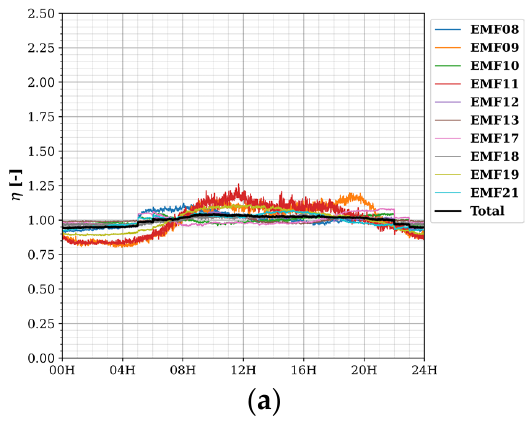
Figure 6. ( a ) Maximum and ( b ) 90% temporal variability of the signals. The maximum variability is calculated as the logarithmic difference of the maximum and minimum electric field samples, 20log 10 (E max /E min ), whereas 90% equals the difference between the 95th and 5th percentiles [13]. All measured exposure levels were low (<0.05%) compared to the ICNIRP reference levels for the general public (e.g., 41 V/m for 900 MHz) [15]. Then, as in [13], temporal profiles (TPs) of the RF exposure were made, which express the average variation of the exposure, η , over a certain time interval (in this case a week and a day). To determine η , the power density samples were first normalized to the average of the considered time interval and then averaged over the entire measuring period. The goal of a TP is to improve (spatiotemporal) interpolation of the RF-EMF exposure (e.g., [13]) by rescaling samples taken at different times of the day or week to the same time instance. For example, a TP can be applied in measurement campaigns where only a single or a few measurements have been performed at each assessment location, each at a different time of day. In this study, both diurnal and weekly temporal profiles (denoted as TP D and TP W , respectively) were created. In contrast to the fixed temporal resolution (denoted as ‘ ∆ t ’) of 1 h in [13], ∆ t of 30 s (i.e., the sampling time of both the fixed (after resampling) and mobile nodes in this study) up to 4 h were investigated here. Diurnal and weekly temporal profiles with ∆ t = 30 s for the four considered frequency bands are shown in Figures 7 and 8, respectively.